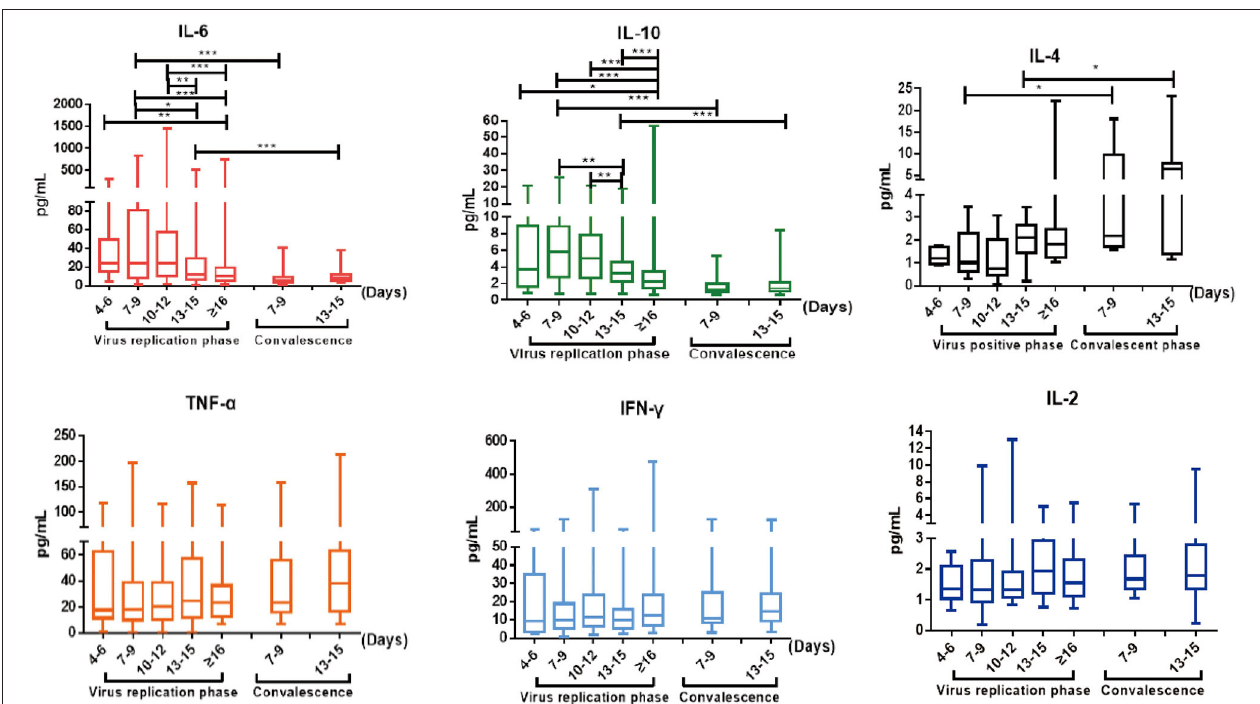
FIGURE 3 | The dynamic changes of IL-6, IL-10, IL-4, TNF- α , IFN- γ , and IL-2 in virus replication phase and early convalescence. Levels of significance: p -value: ***, < 0.001; **, < 0.01; *, < 0.05.